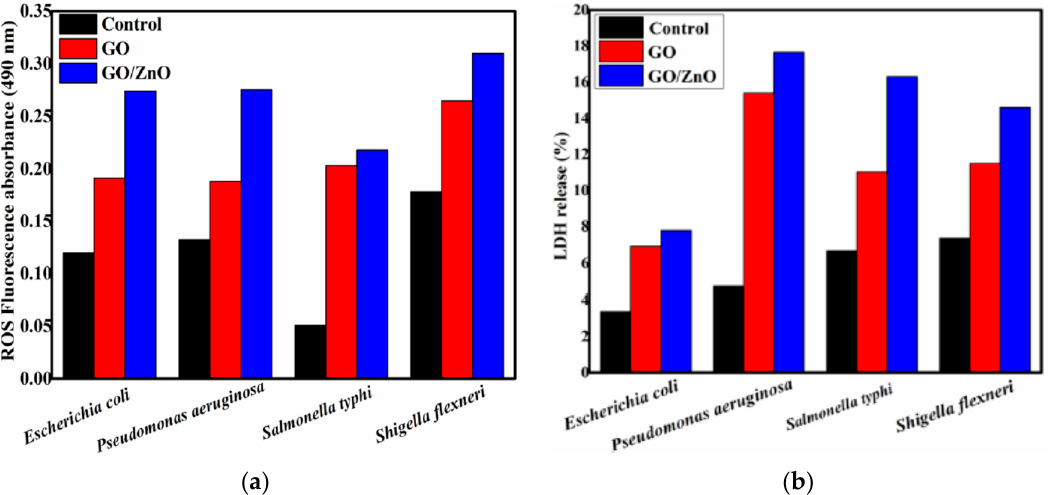
Figure 32. ( a ) ROS and ( b ) lactate dehydrogenase (LDH) levels of different Gram-negative bacteria strains treated with pure GO and GO/ZnO nanohybrid. Reproduced from [246] with permission of Springer Nature.